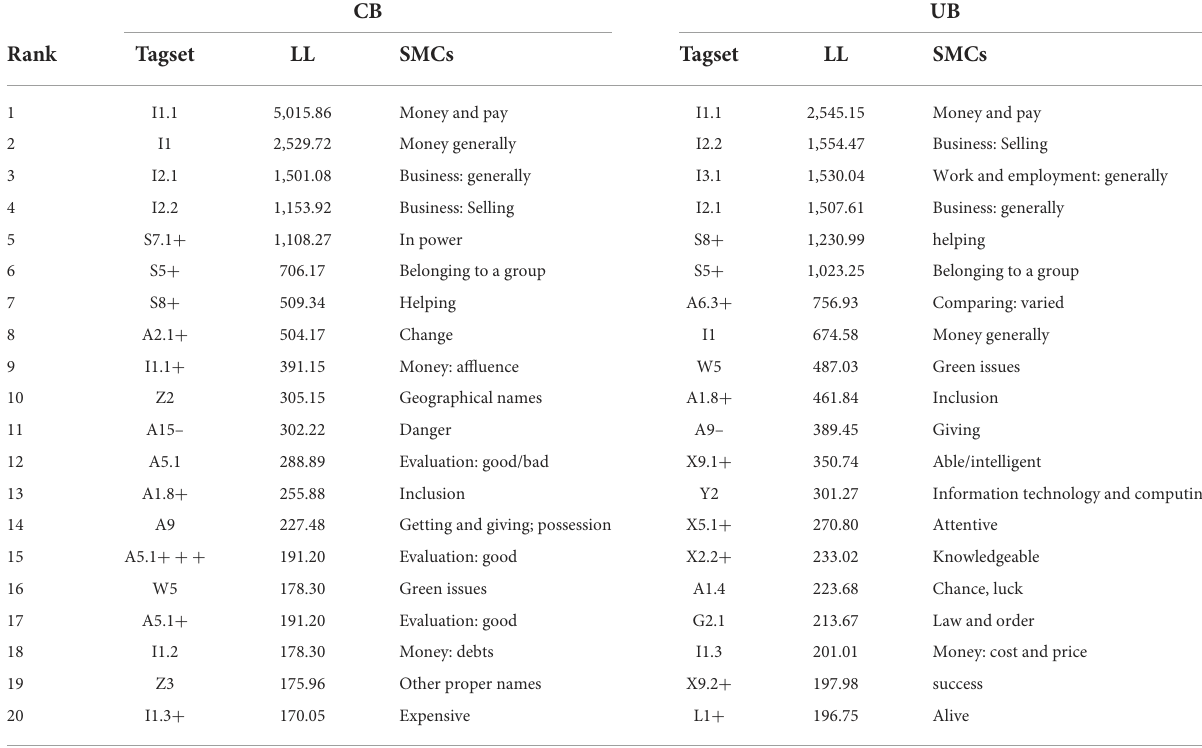
TABLE 3 Top 20 key semantic categories of CB and UB (compared with BNC sampler written).